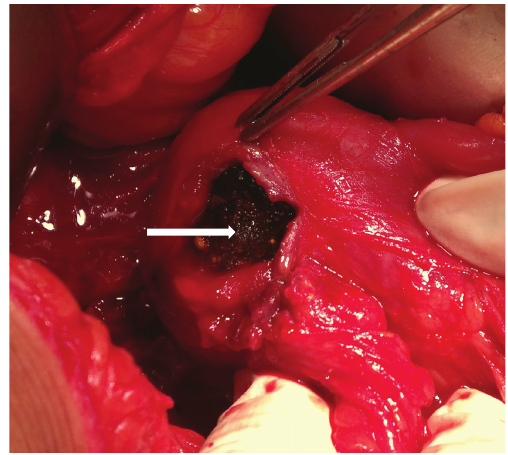
Figure 4: Calculus (arrow) is seen through the duodenotomy incision.